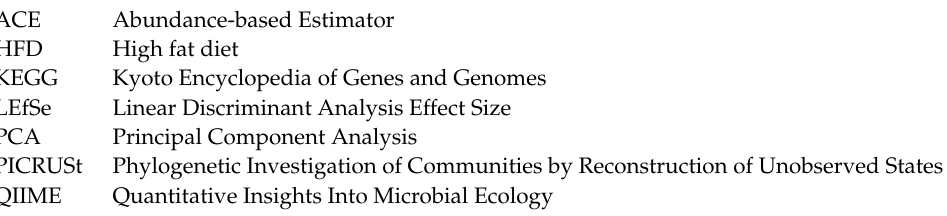
feeding experiment. Table S1: Composition of experimental mouse diets. Table S2: Weekly mea- surements of body weight and feed intake of experimental C57BL/N6 mice. Table S3: Comparison of alpha-diversity indices of the gut microbiota of C57BL/N6 mice. Table S4: Relative abundance of taxonomic groups at phylum level (cut-off > 0.1%). Table S5: Relative abundance of taxonomic groups at genus level (cut-off > 0.1%). Table S6: Relative abundance of predicted KEGG pathways in mice gut microbiota (cut-off >